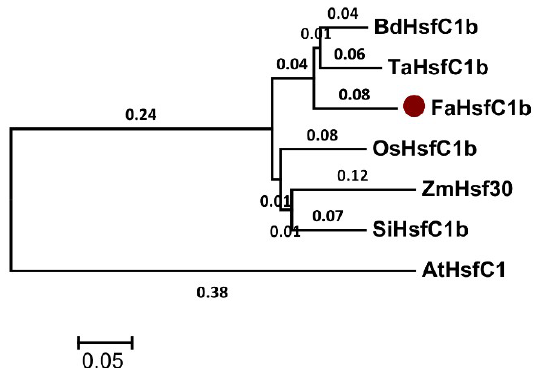
Figure 2. Phylogenetic tree of FaHsfC1b and other HSFC proteins. The tree was constructed by MEGA 5.1 software, based on alignment of complete protein sequences. The red dot indicates FaHsfC1b protein. Accession numbers of protein sequences are listed in materials and methods.